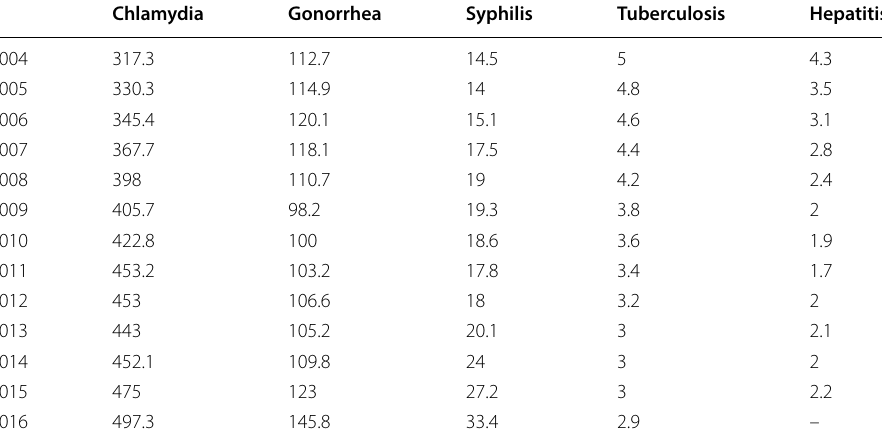
Table 12 CDC reported yearly rates in USA for the examined diseases from 2004 to 2016